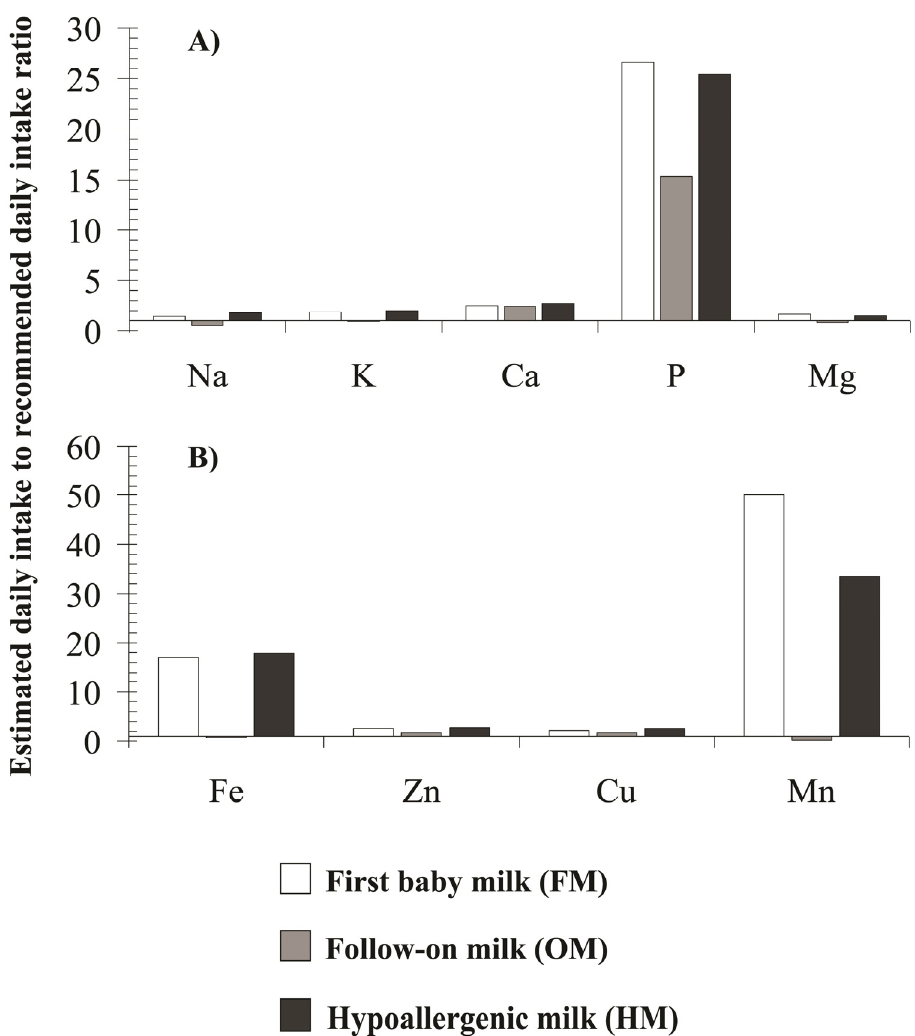
Figure 3. Coverage of the daily nutritional requirement for essential elements contained in analyzed baby milk calculated as estimated daily intake to recommended daily intake ratio. The daily supply of ( A ) macroelements, and ( B ) microelements contained in analyzed baby milk was estimated assuming that the minimum daily amount of the product (as a dry powder) that a child consumes is 100 g. The obtained values were compared to recommend for the Polish population.